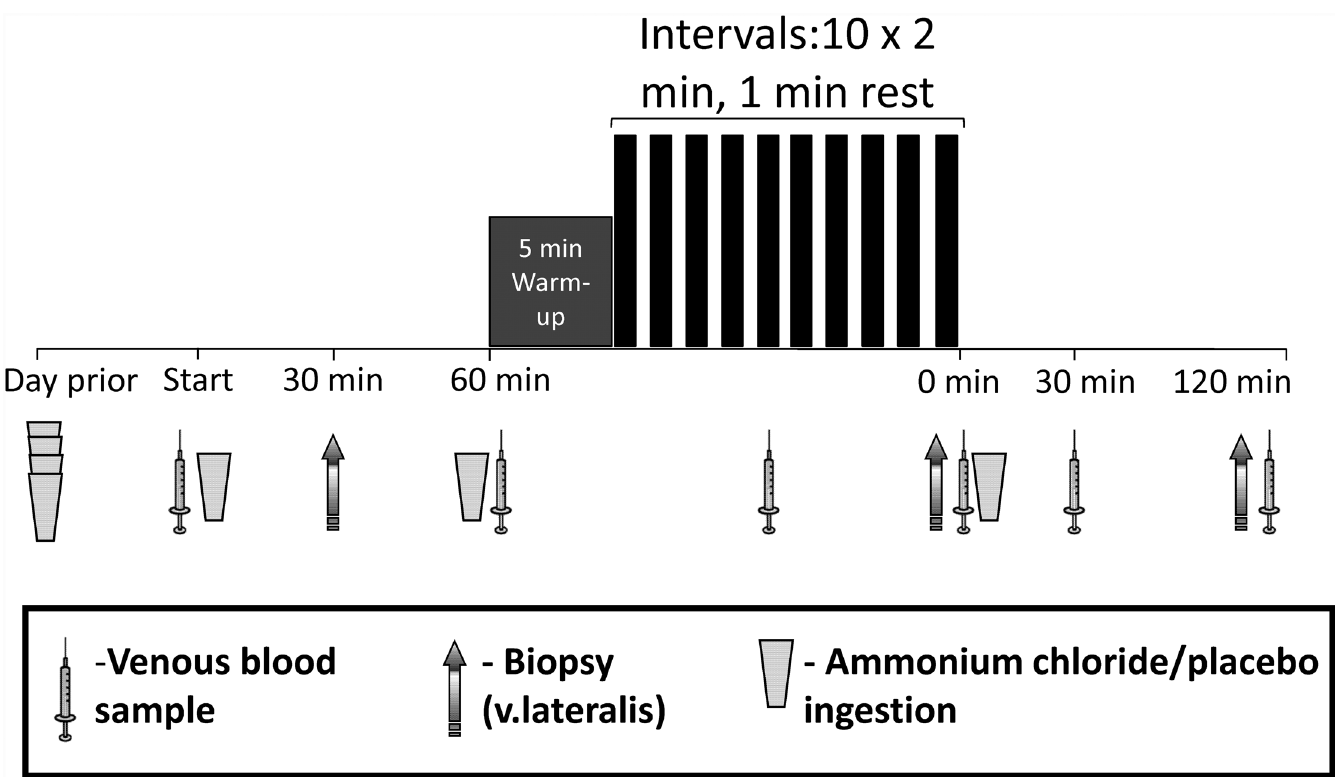
Fig 1. Participants ingested either ammonium chloride (0.15 g.kg -1 , ACID) or placebo (0.15 g.kg -1 , PLA) in four doses during the 24 h prior to the trial day. An 8 min warm-up (5 min at 40% of peak power output, 3 min at 60% of peak power output) was followed by 10 x 2 min intervals at 80% of peak power output, interspersed with 1 min of active rest at 40% of peak power output, performed on a cycle ergometer. Timings of additional supplementation, venous blood and muscle biopsy samples and a post-exercise meal are shown prior to and following the high-intensity interval session.